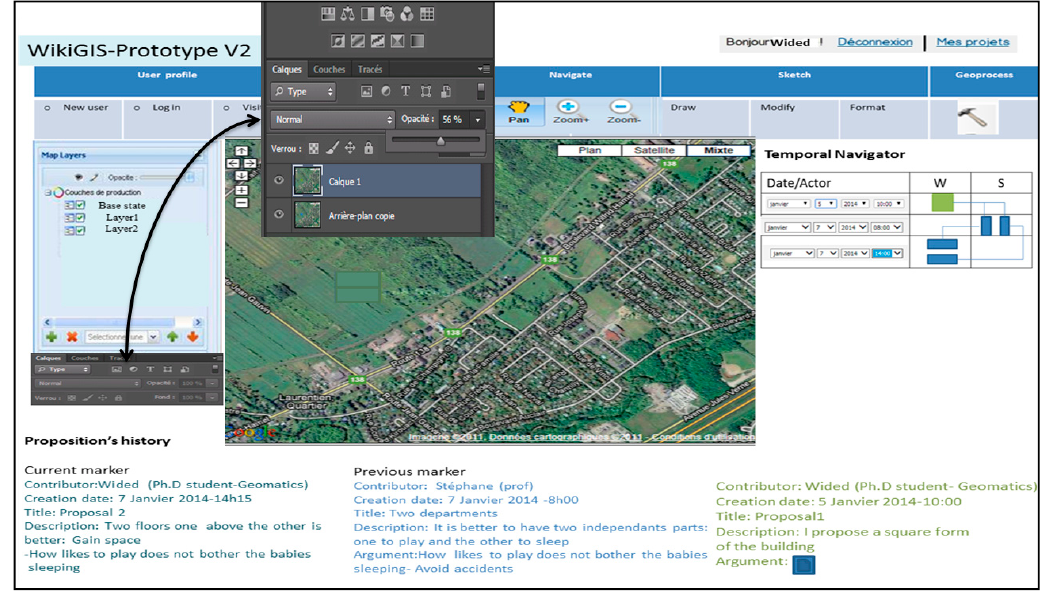
Figure 29. Spatial diff between version 1 and